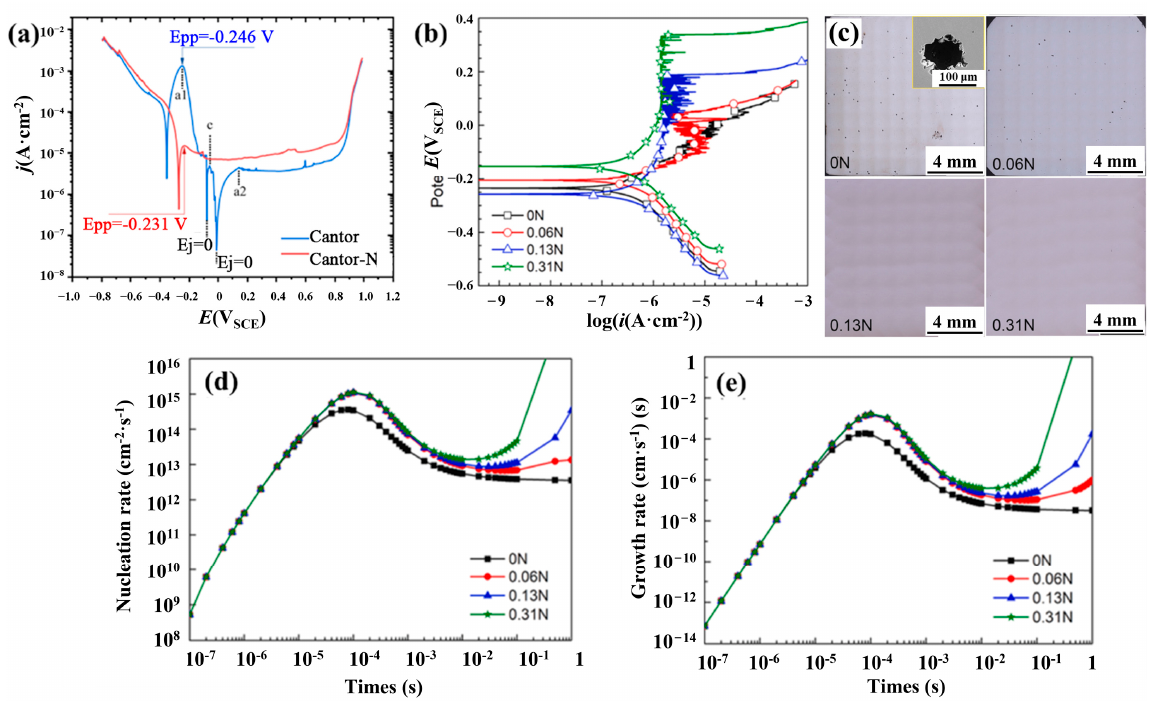
Figure 6. The effect of the addition of N on the polarization behaviors, pitting corrosion performance, and nucleation and growth processes of CoCrFeMnNiN x . ( a ) The potentiodynamic polarization plots for CoCrFeMnNi and CoCrFeMnNiN in 0.1 M H 2 SO 4 aqueous solution; ( b ) potentiodynamic polarization plots for CoCrFeMnNi and CoCrFeMnNiN x in 3.5 wt.% NaCl aqueous solution; ( c ) corrosion morphologies containing enlarged image (inset) after potentiostatic polarization; variation of nucleation rates of ( d ) Cr 2 O 3 and ( e ) Fe 2 O 3 within the passive films of CoCrFeMnNiN x [33,58].